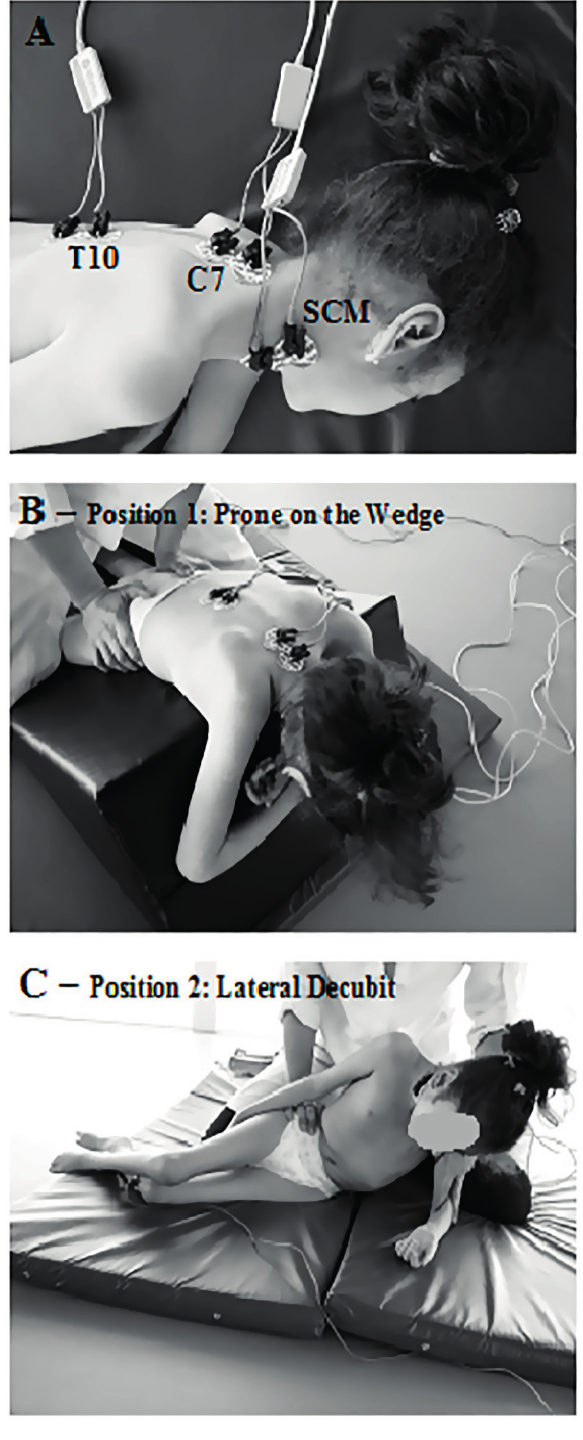
Figure 1 - A) Location of the electrodes for recording activity of extensor and flexor muscles at the C7 and T10 levels and the sternocleidomastoid muscle (SCM); B) Representation of posture 1 recording in the prone position on the wedge; C) Representation of position 2 recording in the lateral decubit on the